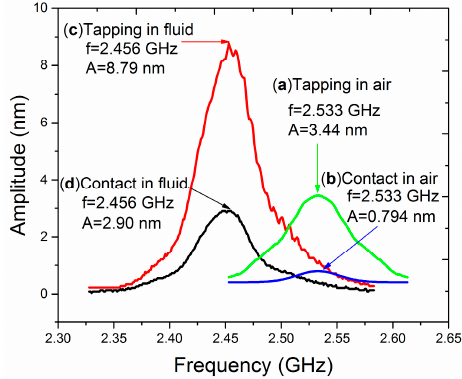
Figure 3 . Amplitude-frequency curve measured in: ( a ) tapping mode in air; ( b ) contact mode in air; ( c ) tapping mode in fluid; and ( d ) contact mode in fluid. ( c ) tapping mode in fluid; and ( d ) contact mode in